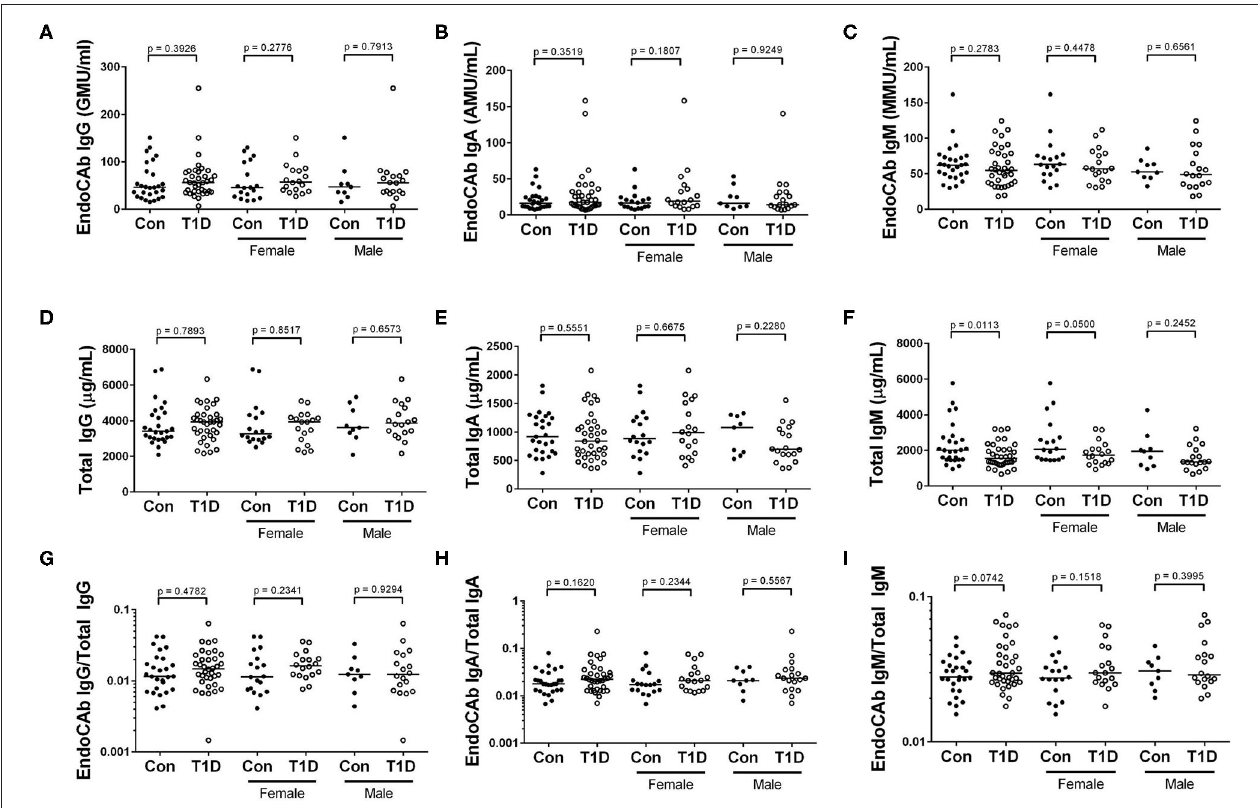
FIGURE 2 | Reduced IgM abundance among T1D subjects, while endotoxin core antibodies (EndoCAb) and total IgG and IgA levels are similar to control. (A–C) EndoCAb IgG, IgA, and IgM levels were similar among T1D subjects and controls. (D–F) We found that total IgG and total IgA were also similar, while total IgM was reduced among T1D subjects. (G–I) Finally, the ratio of EndoCAbs to total immunoglobulins were more-or-less equivalent for IgG, IgA, and IgM. Bars represent median values.